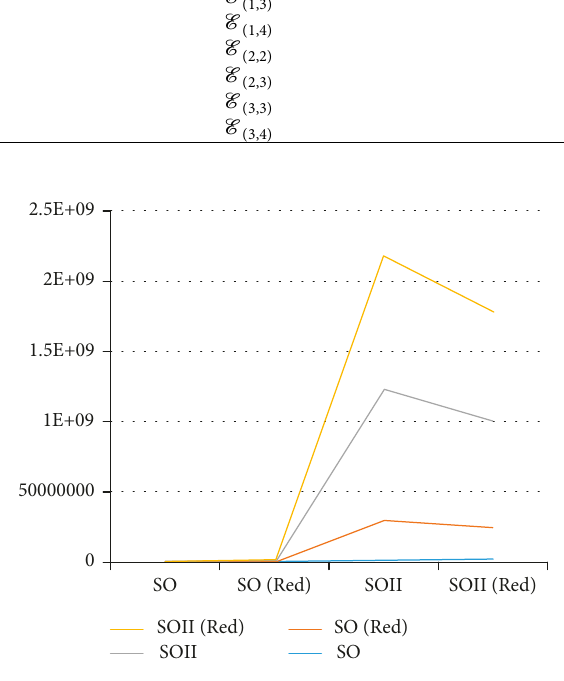
, SOII, and SOII red red